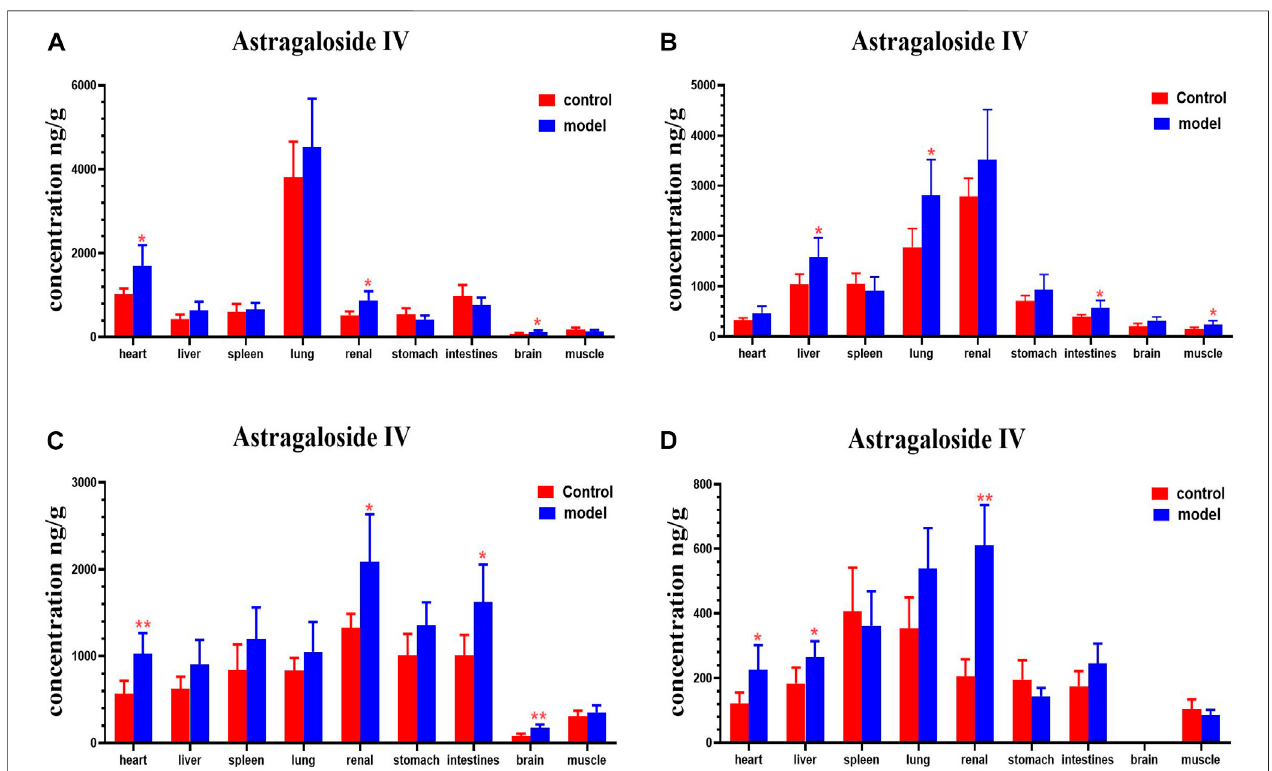
FIGURE 10 | Content of astragaloside IV in different mouse tissue homogenate of the normal and DN models at four different time points after intragastric administration of HQD (x±SD, n =8), (A) 30 min, (B) 2 h, (C) 4 h, (D) 8 h. Ps: *P < 0.05, **P < 0.01 vs. normal group.